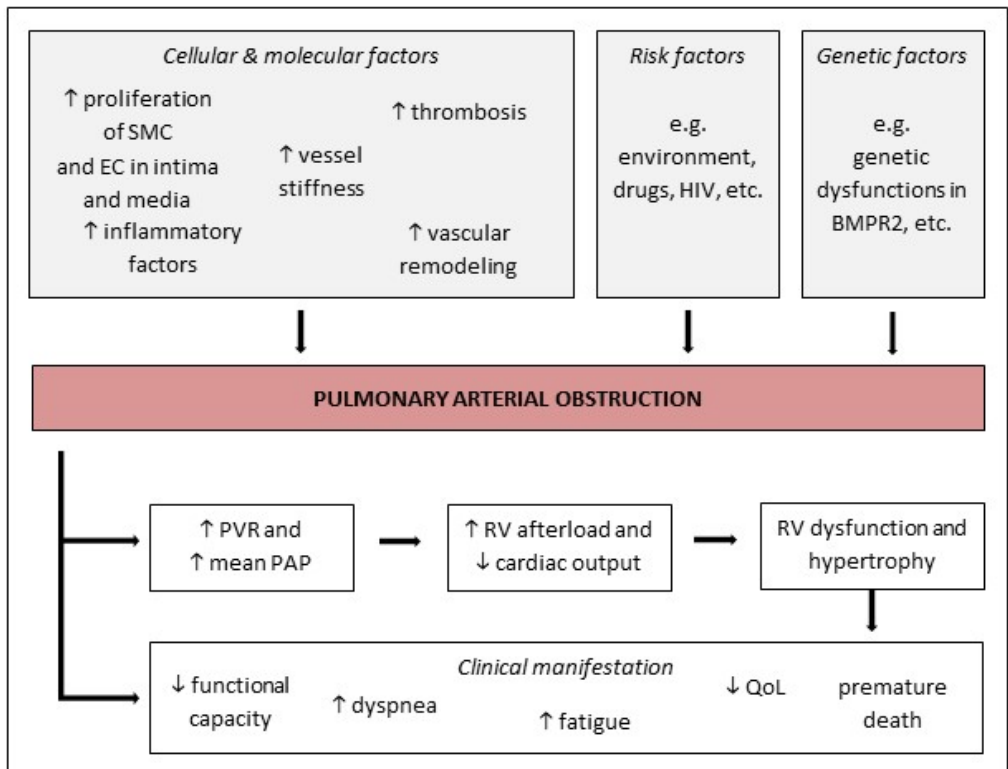
Figure 1. The multifactorial etiopathogenesis of PAH. The pathogenesis of PAH implicates several molecular and cellular factors such as an increased proliferation of SMCs and ECs in the tunica intima and media. Risk factors (e.g., drugs) and genetic factors (e.g., dysfunctions in BMPR2) are also discussed to be involved in pathogenesis. PAH is characterized by an increased PVR and mean PAP ≥ 20 mmHg at rest, progressively leading to right ventricular hypertrophy (RVH), further resulting in right heart failure, loss of functional capacity and premature death. BMPR2, bone morphogenetic protein receptor type II; EC, endothelial cell; HIV, human immunodeficiency viruses, QoL, quality of life; SMC, smooth muscle cells; PAP, pulmonary arterial pressure; PVR, pulmonary vascular resistance ( ↑ = increased; ↓ =